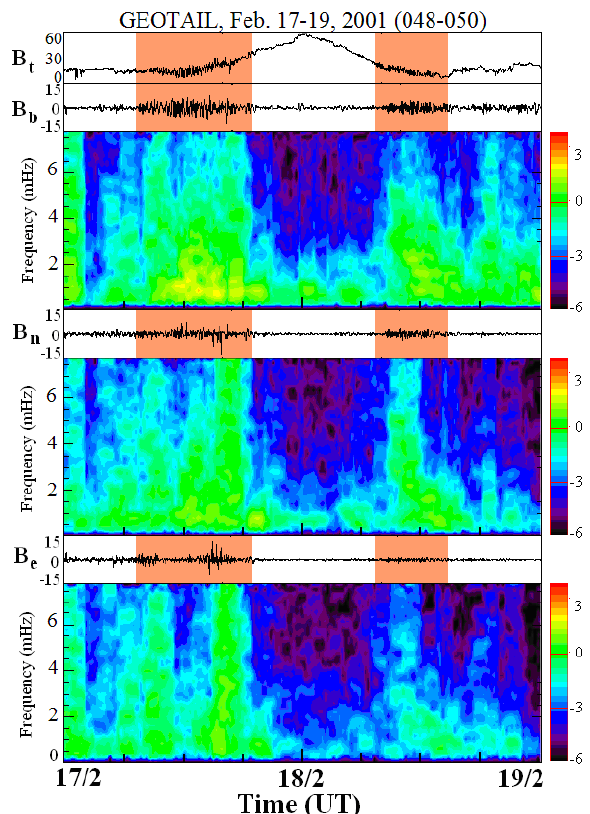
Fig. 5. A sequence of 2 days of Geotail magnetometer measure- ments, from 17 to 19 February 2001. The total magnetic field and the three components in the Magnetic Field Aligned coordinate sys- tem are plotted in black & white, in nT, as marked; the correspond- ing Dynamic Power Spectra are plotted below in color, in nT 2 /Hz. The two orange-shaded time periods in each MFA component mark the regions of intense ULF fluctuations in Geotail data; the corre- sponding extent along Geotail’s orbit is also marked in orange in Fig.